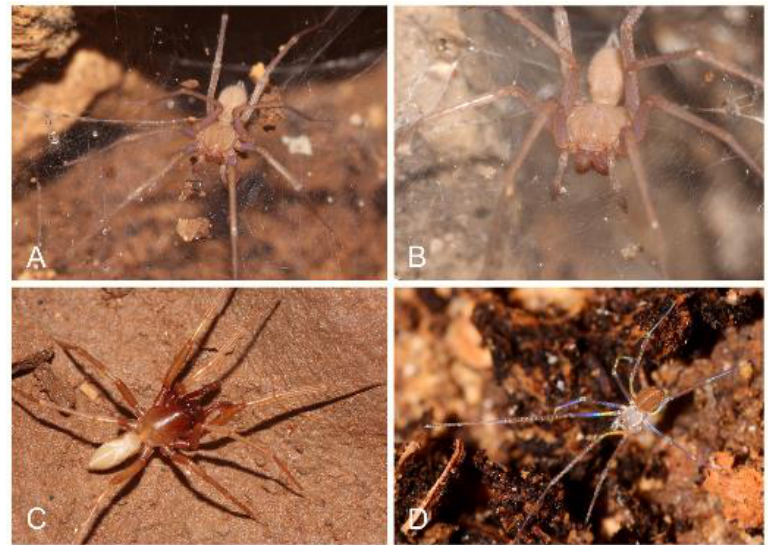
Figure 6. Troglobite spiders found during cave surveys (cave numbers in parentheses). ( A , B ): Tegenaria Latreille, 1804 (Agelenidae). ( A ): Tegenaria from Yir’on large cave (upper Galilee, 2); ( B ): Tegenaria from Teomim large cave (Judean mountains, 24); ( C ) Harpactea Bristowe, 1939 (Dysderidae) eyeless species from Shetula large cave (upper Galilee, 1); ( D ): Cataleptoneta edentula Denis, 1955 (Leptonetidae) from Ezba’ large cave (Karmel ridge, 12). Pictures: Shlomi Aharon.